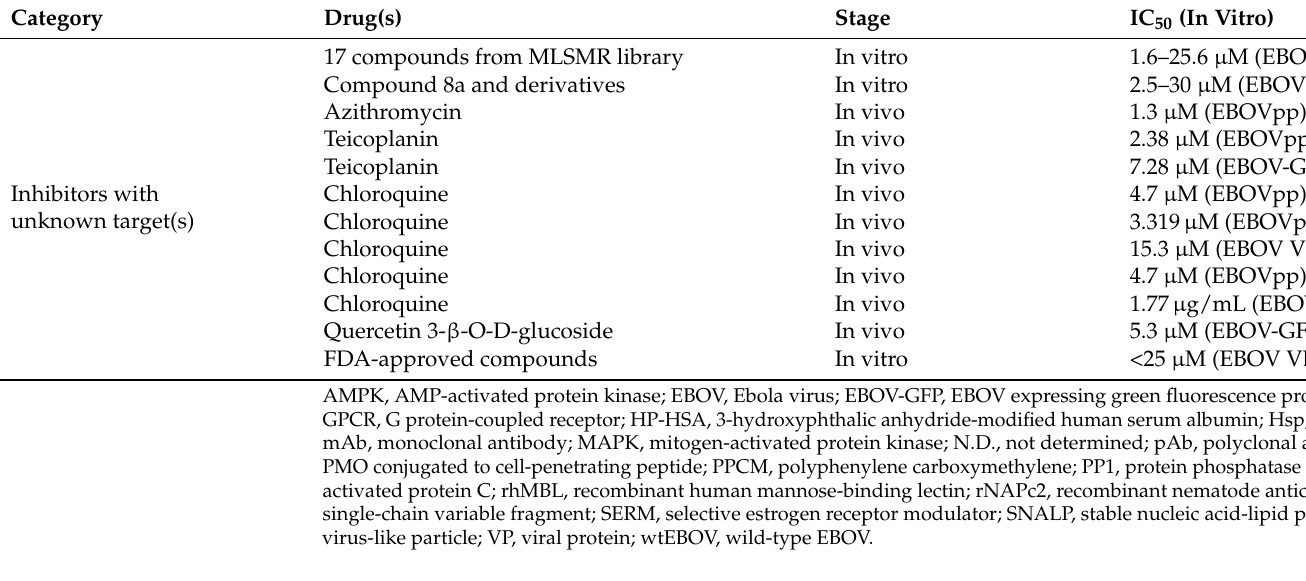
Table 2. Animal studies of EBOV antiviral